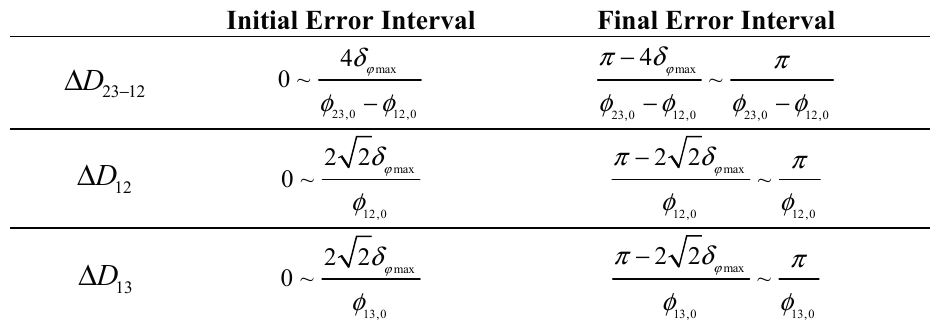
Table 1. The initial error interval and the final error interval under various reference phase